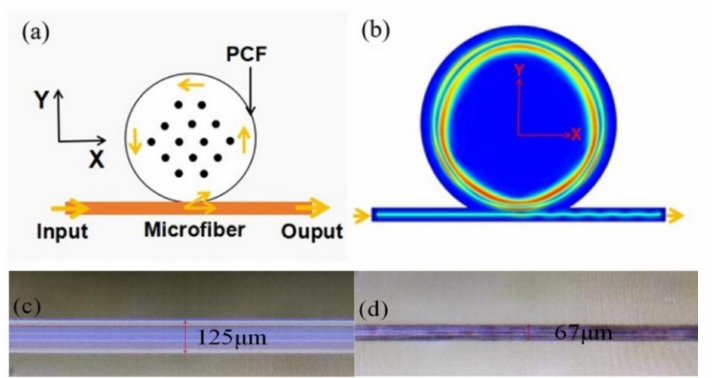
Figure 1. ( a ) Schematic diagram of the PCF infiltrated with nanostructured magnetic fluid coupled with a tapered microfiber. ( b ) Mode field distributions in x-y plane. ( c ) Micrograph of PCF before being infiltrated. ( d ) Micrograph of PCF after being infiltrated and